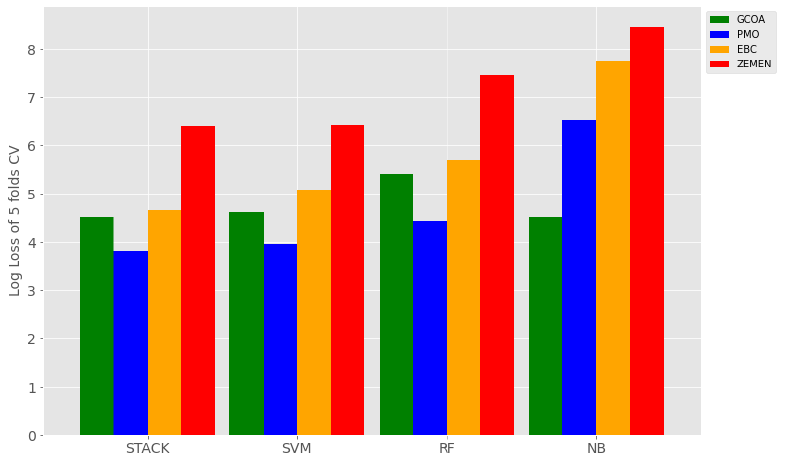
Figure 7. Comparison of the performance of the proposed stacking sentiment classifier with base machine learning classifier across the four data sets using TF‑IDF character (1,7) grams + SMOTE using log